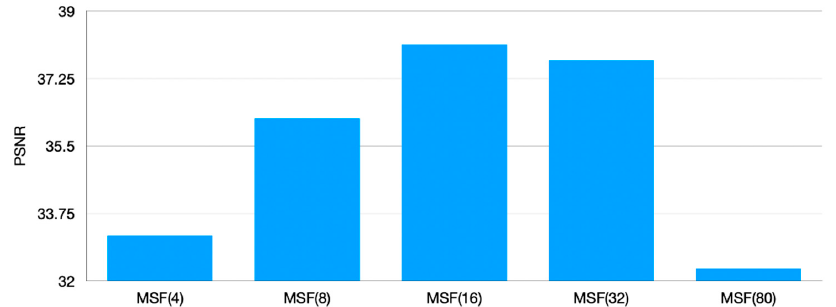
Figure 11. Comparison among MSF with different number of subordinate networks.